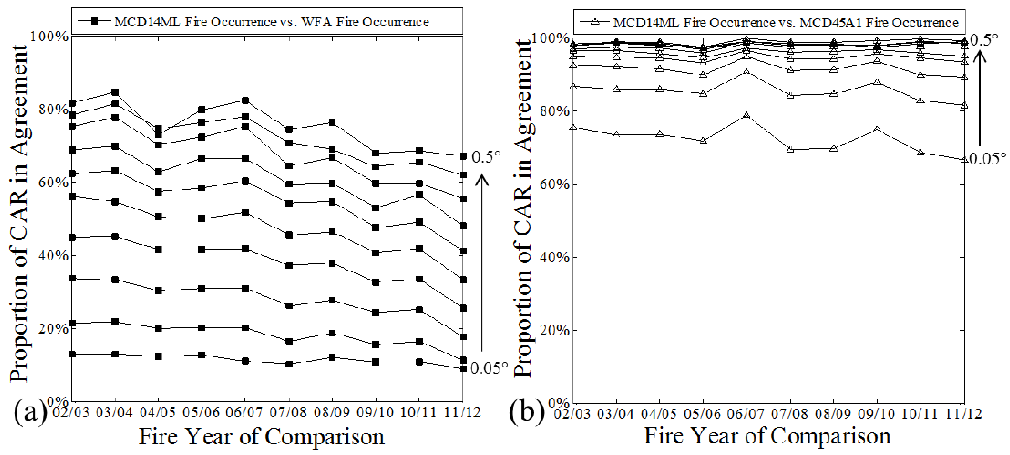
Figure 3. Comparison of annual fire occurrence maps in the CAR for individual years during the study period. Comparisons between maps derived from the MCD14ML and WFA active fire products ( a ), and between the MCD14ML active fire product and MCD45A1 burned area products ( b ), are based on the proportion of grid cells in the CAR that contained: (i) at least one fire pixel recorded in both datasets; or (ii) no fire pixels recorded in either dataset. Each temporal profile (solid line) coincides with a particular grid cell resolution, ranging from 0.05° to 0.5° in